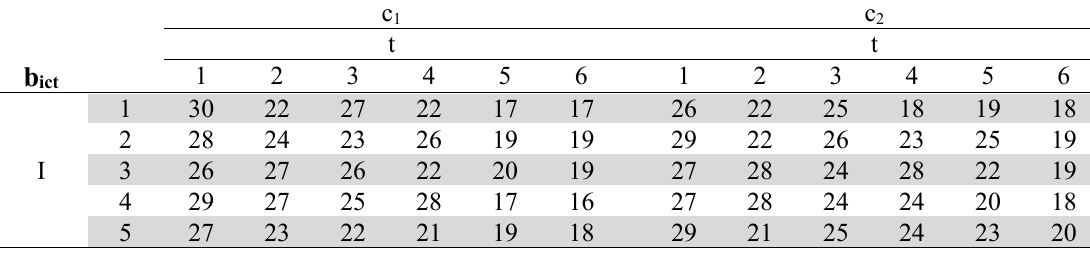
Return of projects